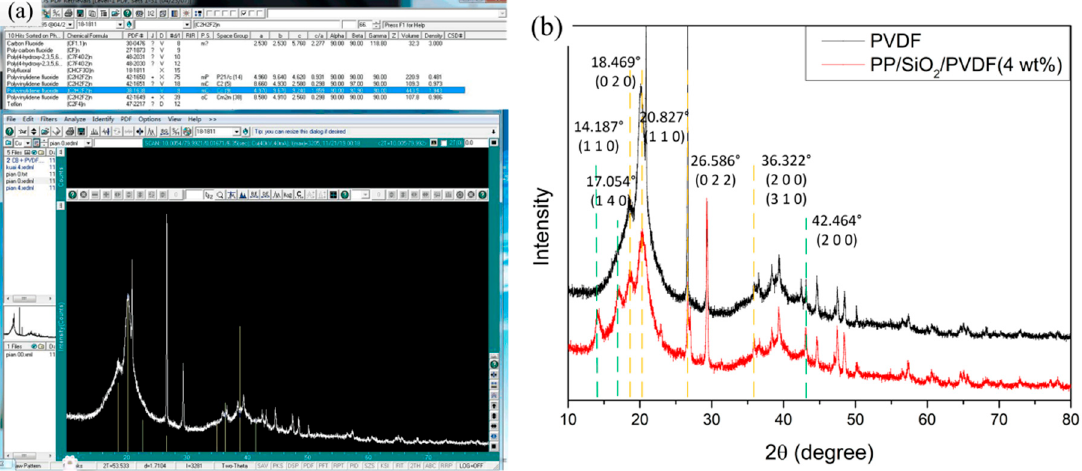
Figure 11. XRD analysis of samples: ( a ) Jade (XRD analysis software) and ( b ) curve of XRD.